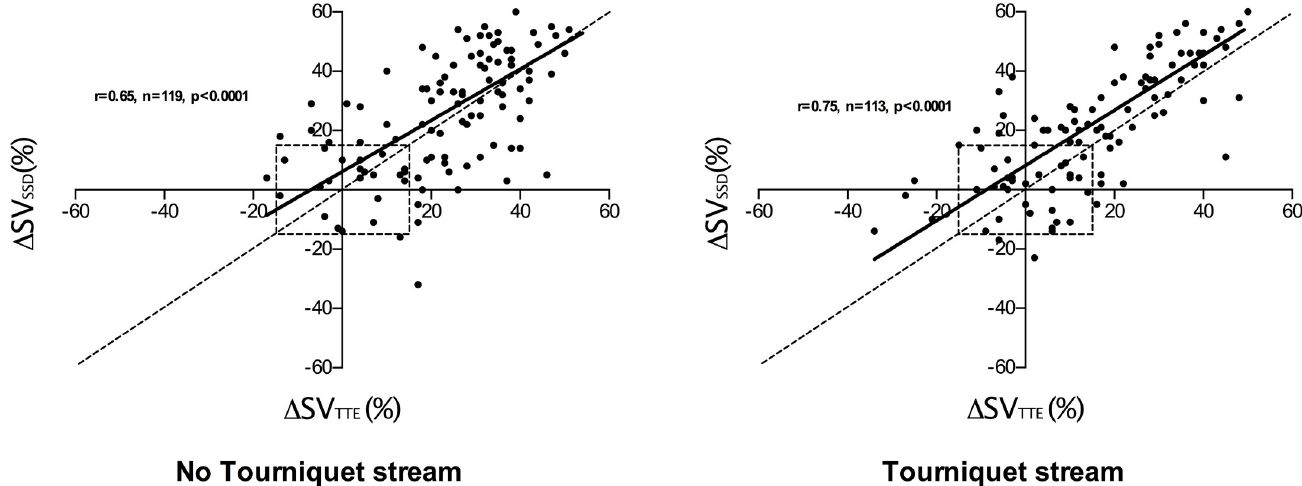
Fig 5. 4 quadrant plot showing changes in stroke volume from baseline ( Δ SV) recorded using supra-sternal Doppler (SSD) and trans-thoracic echocardiography (TTE). 15% exclusion zone shown as dotted central square. Line of identity (y = x) shown as dotted line and regression line shown as solid line. r value indicates degree of correlation (Pearson’s